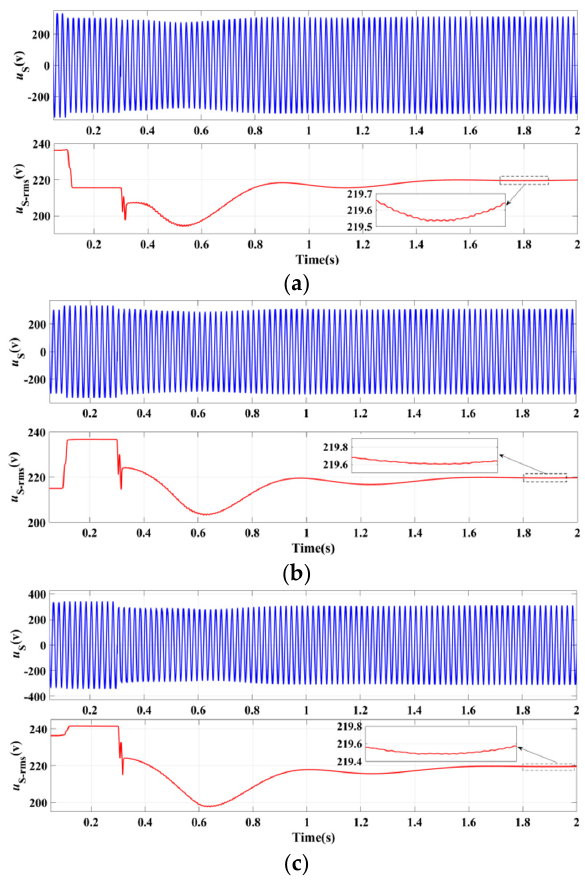
u when the ES uses the PI controller: ( a ) capacitive mode, ( b ) Figure 8. Waveform and RMS of Figure 8. Waveform and RMS of u S when the ES uses the PI controller: ( a ) capacitive mode, S resistive mode, ( c ) inductive mode. ( b ) resistive mode, ( c ) inductive